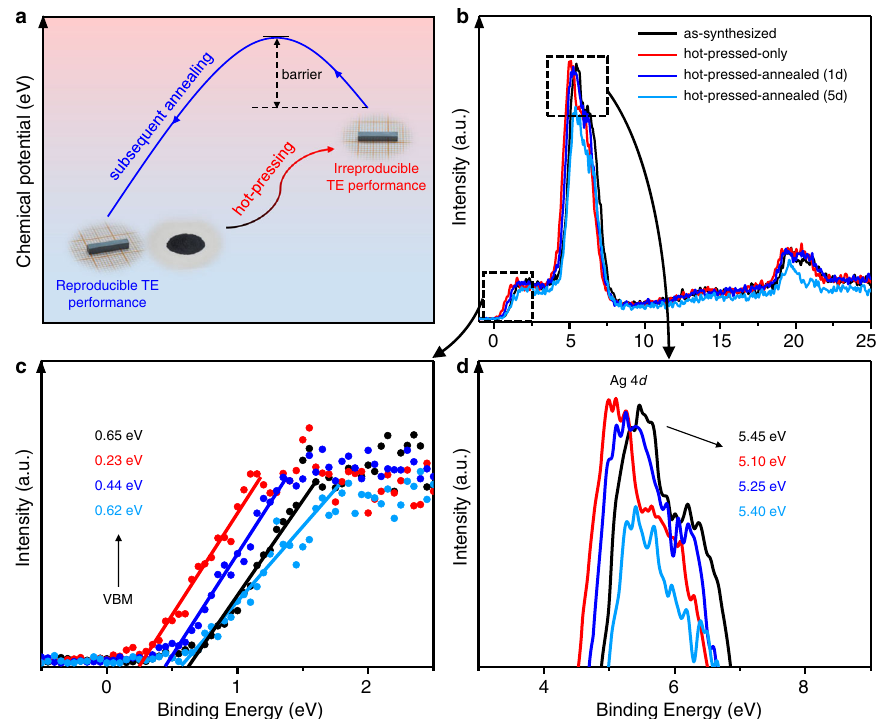
Fig. 6 Chemical potential of Ag 9 GaSe 6 samples. a Sketch illustration of the change of the chemical potential during the sample condensation process. b VBXPS spectra of the as-synthesized, hot-pressed-only and hot-pressed-annealed samples. For the latter, samples annealed for 1 or 5 day(s) are presented. c The edge of the valence band maximum and d the characteristic peak of the Ag 4 d